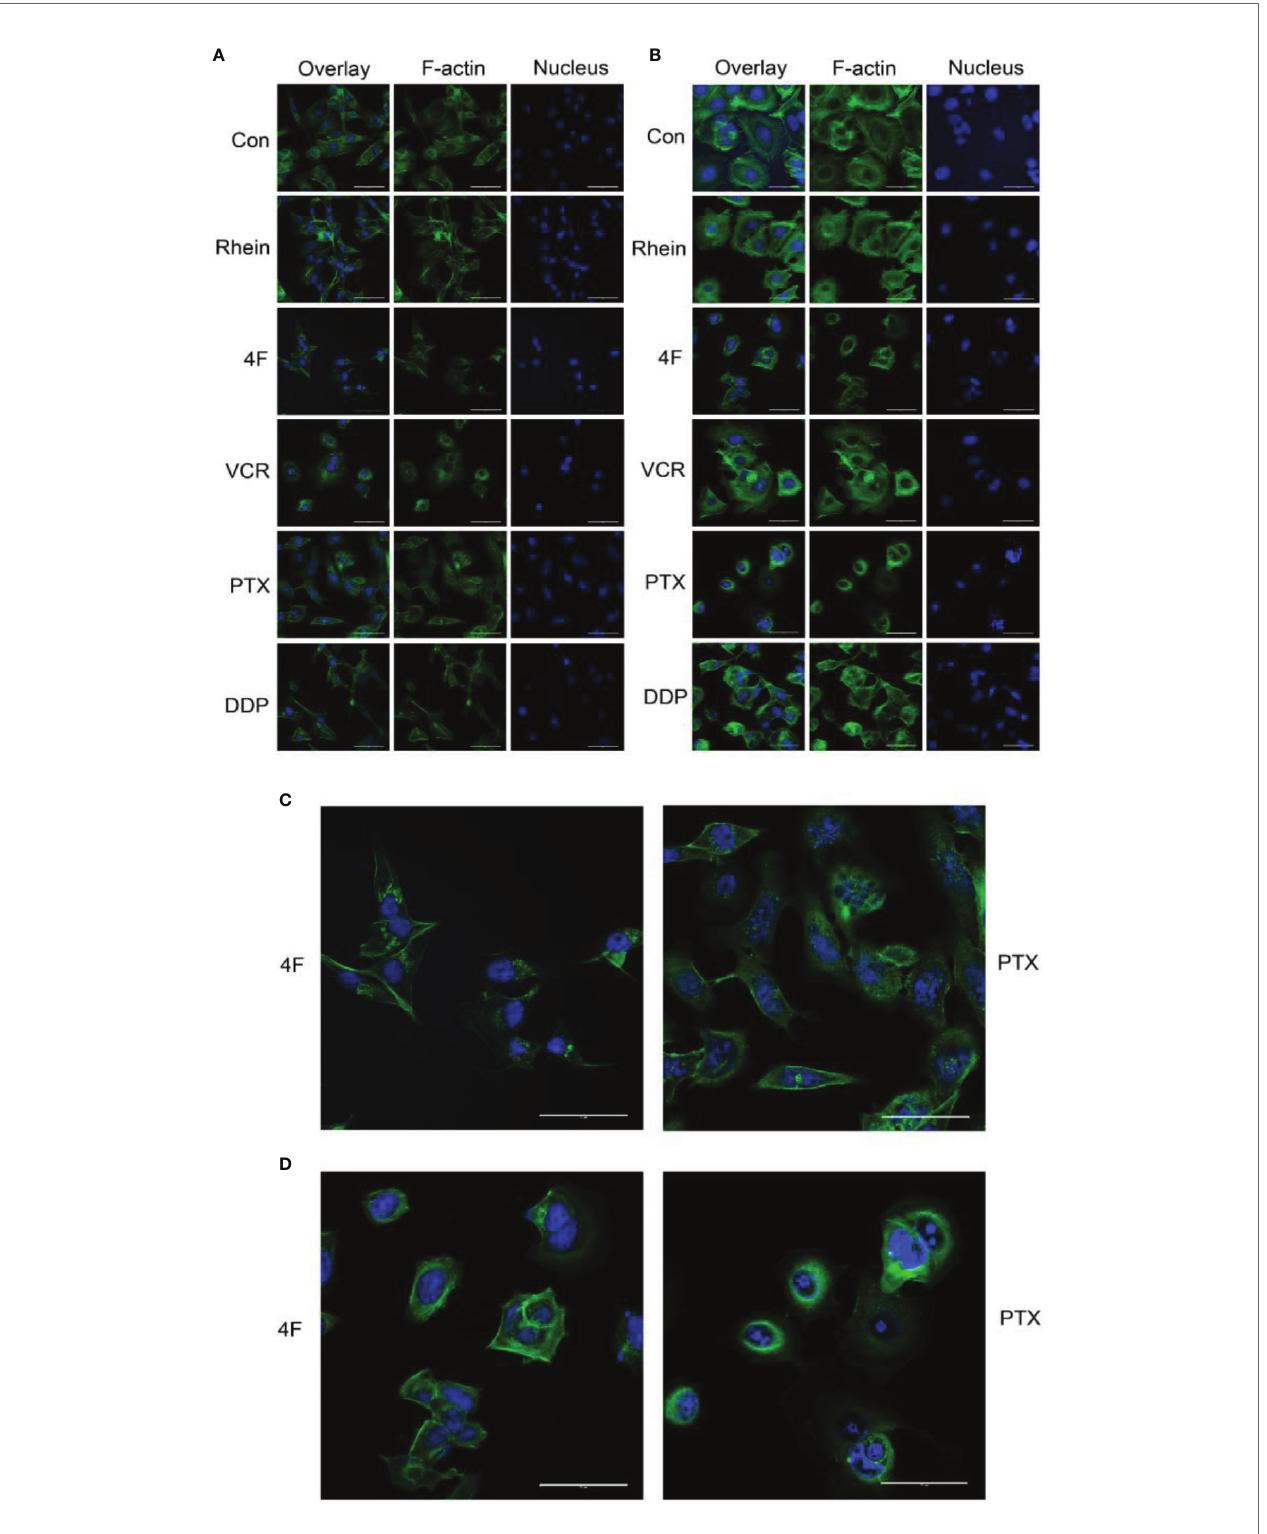
FIGURE 4 | Laser confocal microscopy to detect the effects of different drugs on the cytoskeleton of breast cancer cells (scale bar: 50 m m). F-actin and the nucleus appear in green and blue, respectively. (A) Cytoskeletal changes after drug treatments in MDA-MB-231 cells. (B) Cytoskeletal changes after drug treatments in MCF- 7 cells. (C) MDA-MB-231 cells treated with derivative 4F and PTX (scale bar: 50 m m). (D) MCF-7 cells treated with derivative 4F and PTX (scale bar: 50 m